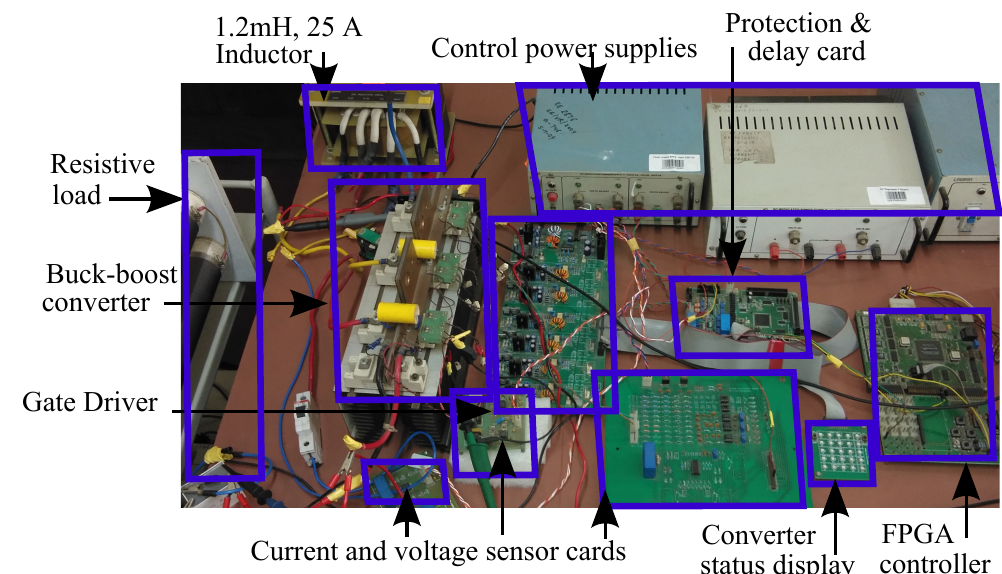
Figure 9. Picture of the high power PV characterization hardware set-up with different subsystems marked. IGBT based buck-boost switched mode power converter characterizing 1.2 kW rated rooftop solar panels via input filter.